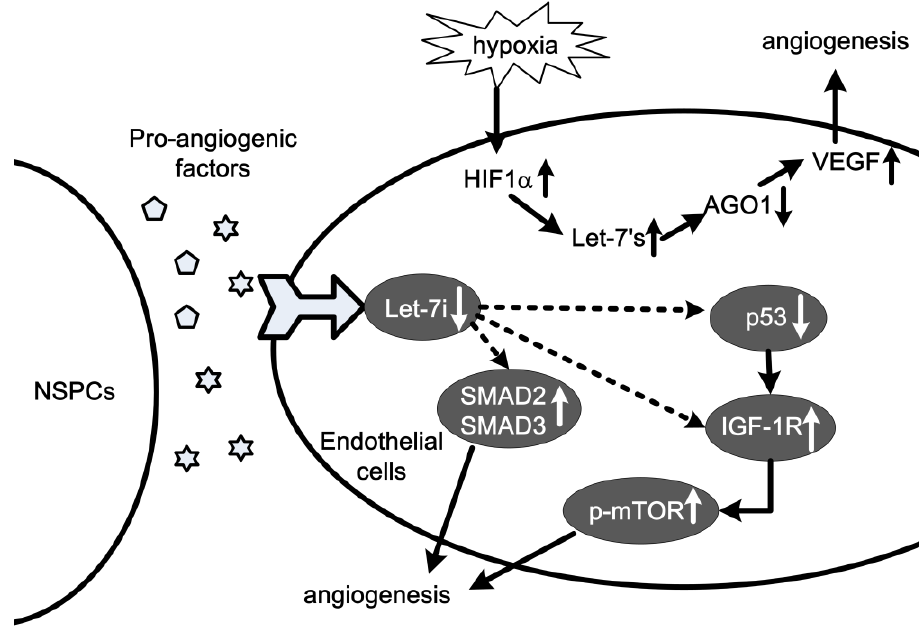
Figure 3. Roles and signaling pathways of let-7 in hypoxia- and neural stem/progenitor cells (NSPCs)-induced angiogenesis. Hypoxia treatment on endothelial cells (ECs) induced angiogenesis through hypoxia-inducible factor 1α (HIF1α)/let-7s/(AGO1)/VEGF signaling pathway. In ECs co-incubated with NSPCs, pro-angiogenic factors released by the NSPCs induced angiogenesis through SMAD2 (SMAD3), and p53/IGF-1R/p-mTOR signaling